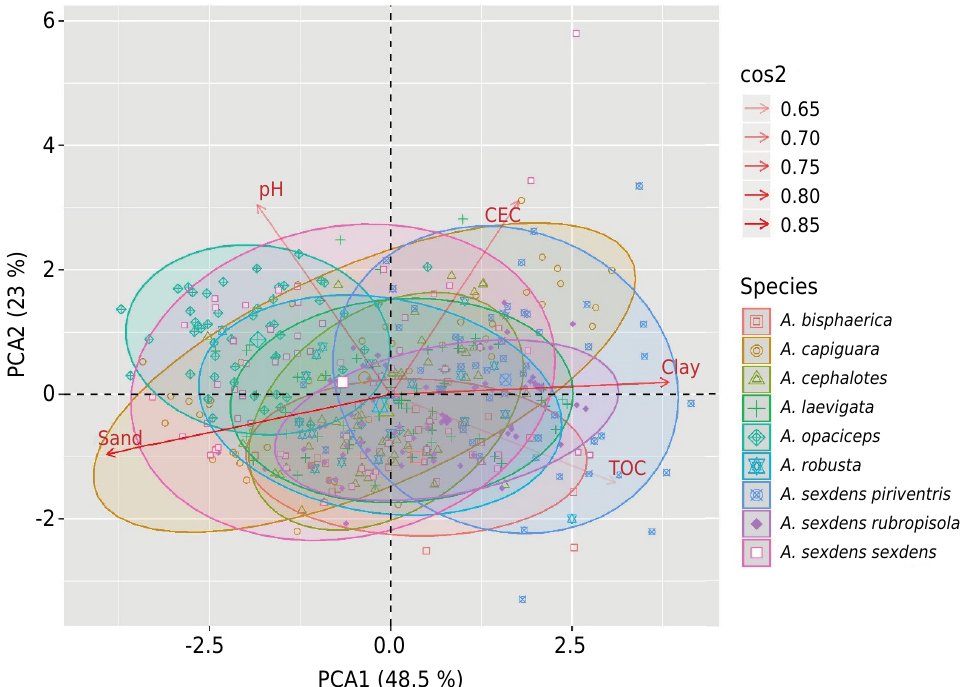
Figure 3. Principal Component Analysis (PCA) of relations between the Atta species points and soil properties. The soil variables are Total Organic Carbon (TOC), cation exchangeable capacity (CEC), pH, sand, and clay. Pearson correlation of each vector is indicated in